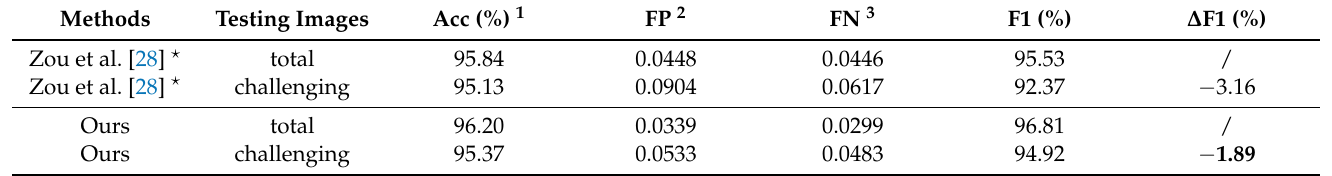
Table 6. Robustness comparison with the best method [28] in the Tusimple benchmark. The less the ∆ F1 is, the higher robustness of the method. (cid:63) means reproduced results by using its source code.